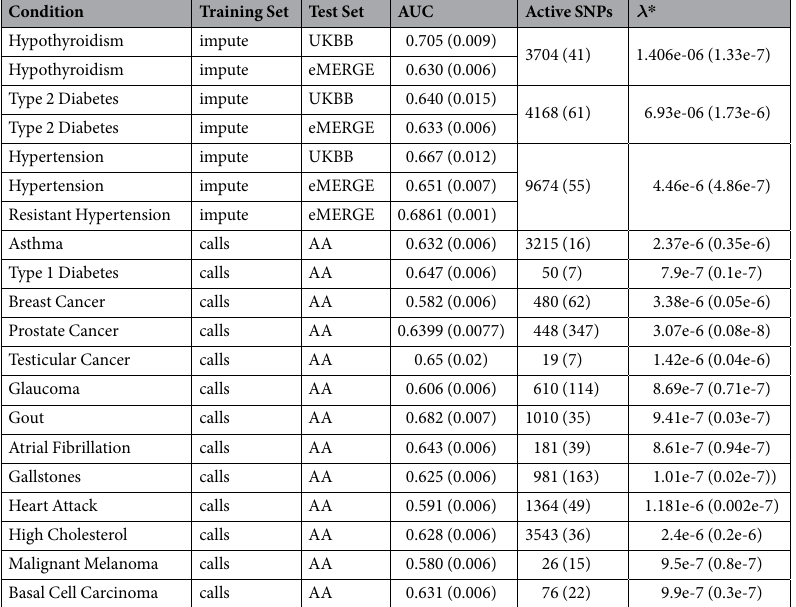
Table 2. Table of genetic AUCs using SNPs only - no age or sex. Training and validating is done using UKBB data from either direct calls or imputed data to match eMERGE. Testing is done with UKBB, eMERGE, or AA as described in Secs. 2 and Supplementary Information Sec. D. Numbers in parenthesis are the larger of either a standard deviation from central value or numerical precision as described in Sec. 2. λ * refers to the lasso λ value used to compute AUC as described in Sec. 2.